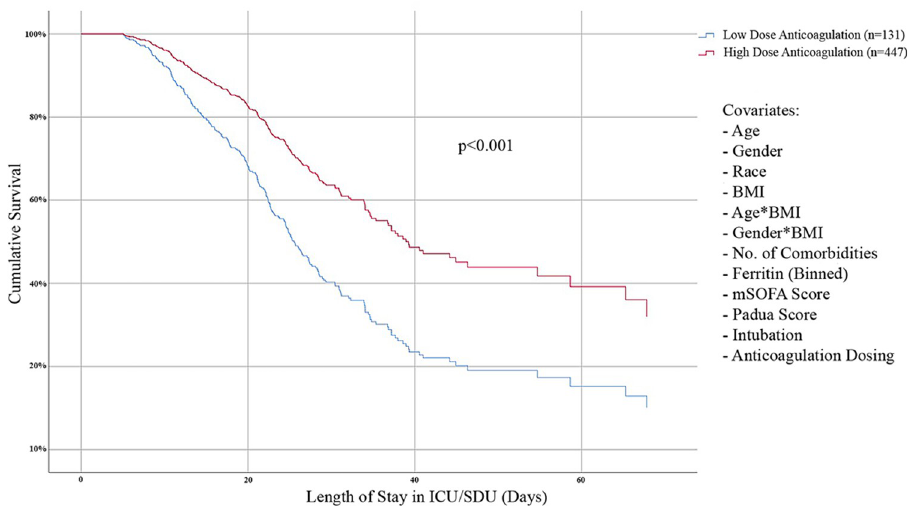
Fig 2. Cox proportional hazard cumulative survival (all cause inpatient mortality) for critically ill patients receiving high versus low dose anticoagulation after adjusting for the listed